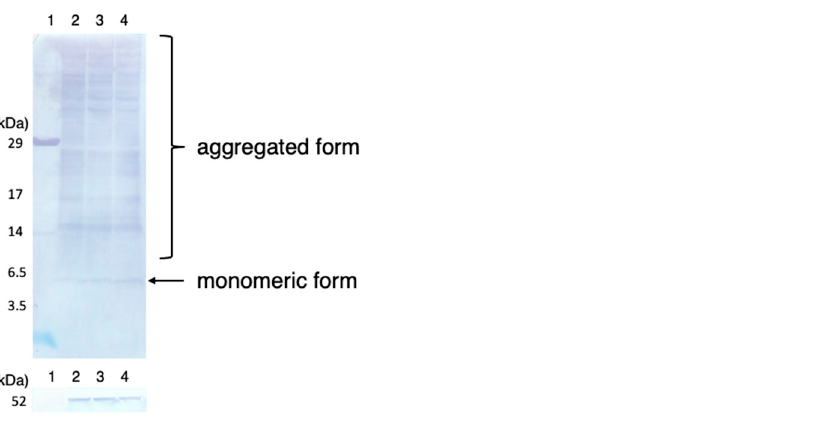
Figure 5. Accumulation of A β peptides in B 12 − , B 12+ , and B 12 − +AsA-2G GMC101 worms. The